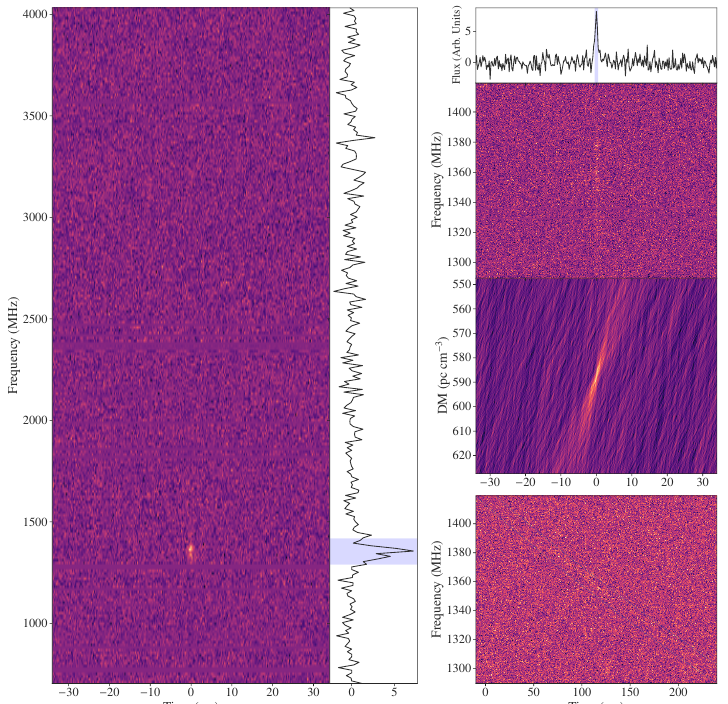
Figure 3. Figure 3 from [67] “Extremely band-limited repetition from a fast radio burst source”, reproduced with permission from Pravir Kumar; published by MNRAS (RAS Publishing), 2021. The left plot shows the full band of the UWL receiver at Parkes with the FRB barely distinguishable from interference at frequencies below 1500 MHz. The right plot shows the profile, its band-limited dynamic spectrum and the diagnostic plots of DM vs time and dispersed dynamic spectrum hinting to the real FRB nature of the